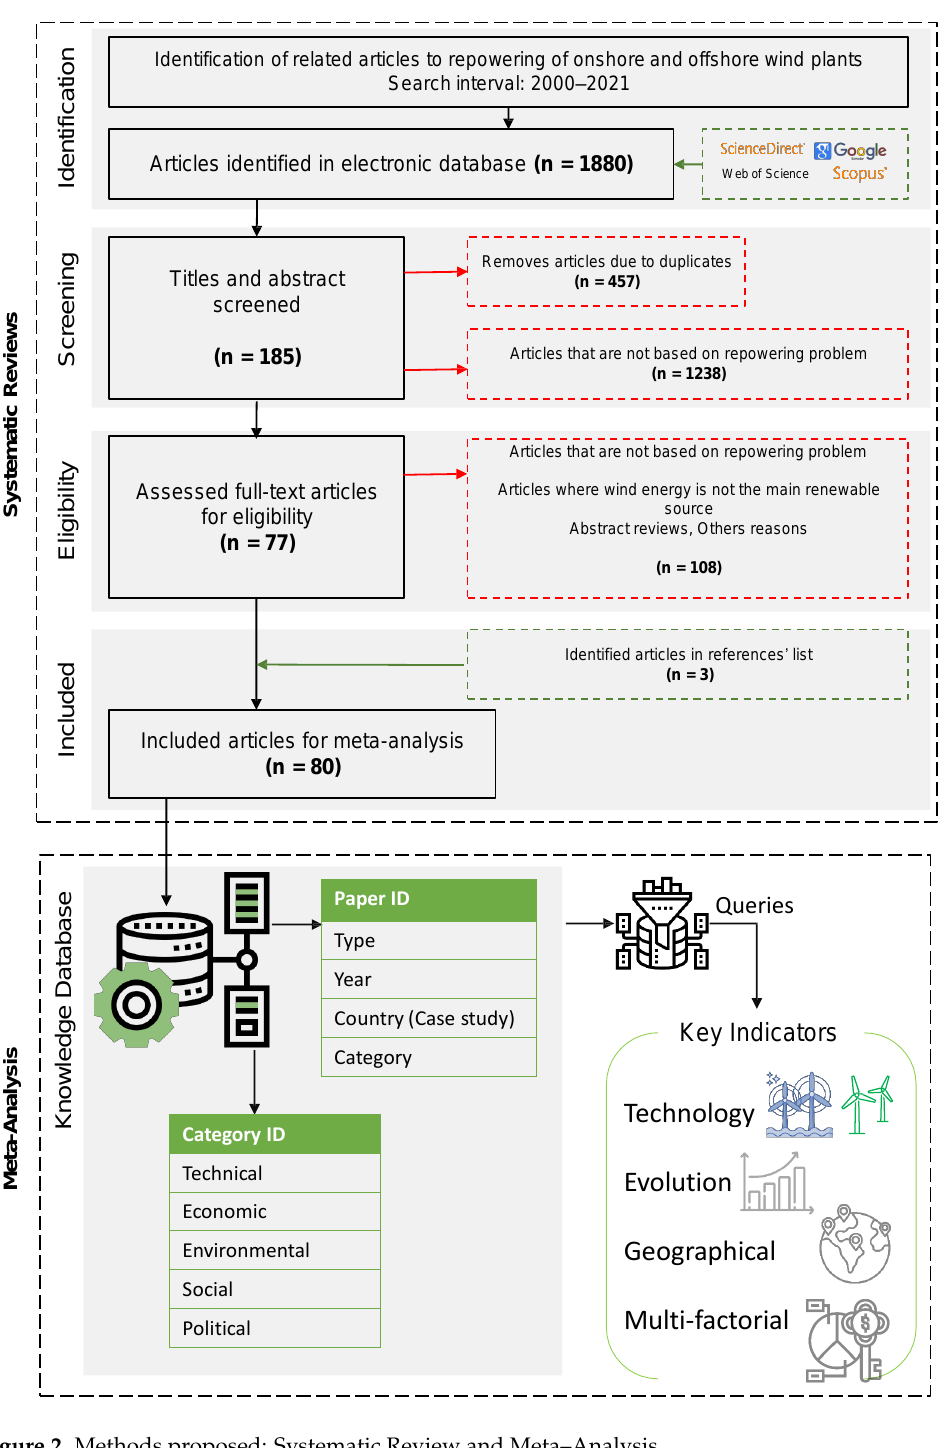
Figure 2. Methods proposed: Systematic Review and